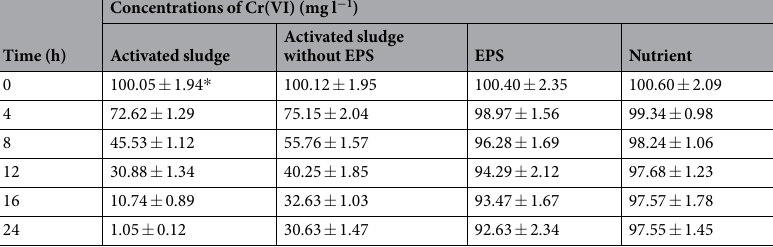
Table 2. The Cr(VI) reducing capability of activated sludge, activated sludge without EPS, EPS and nutrient. * Represent standard deviation (s.d.).